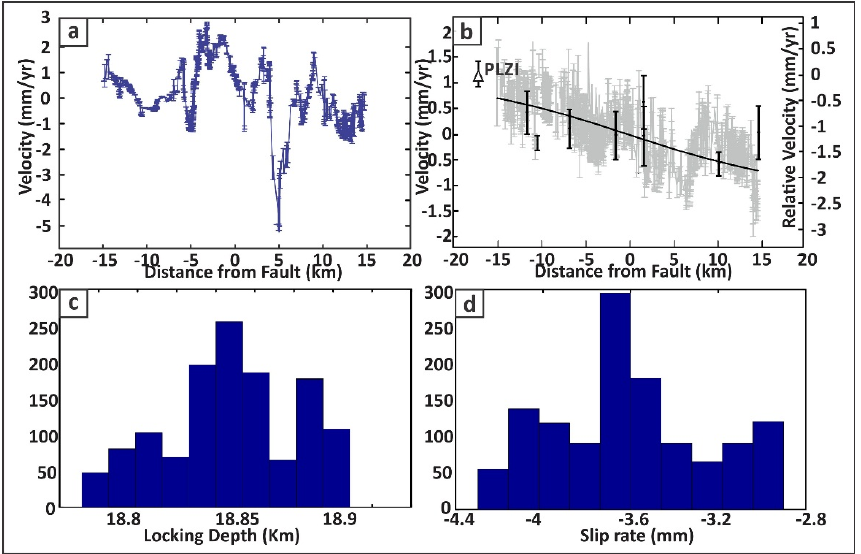
Figure 13. 2007–2010 fault-parallel velocity pro fi le derived from ALOS data using ( a ) StaMPS and ( b ) ISBAS method. Probability distribution for the ( c ) locking depth and ( d ) slip